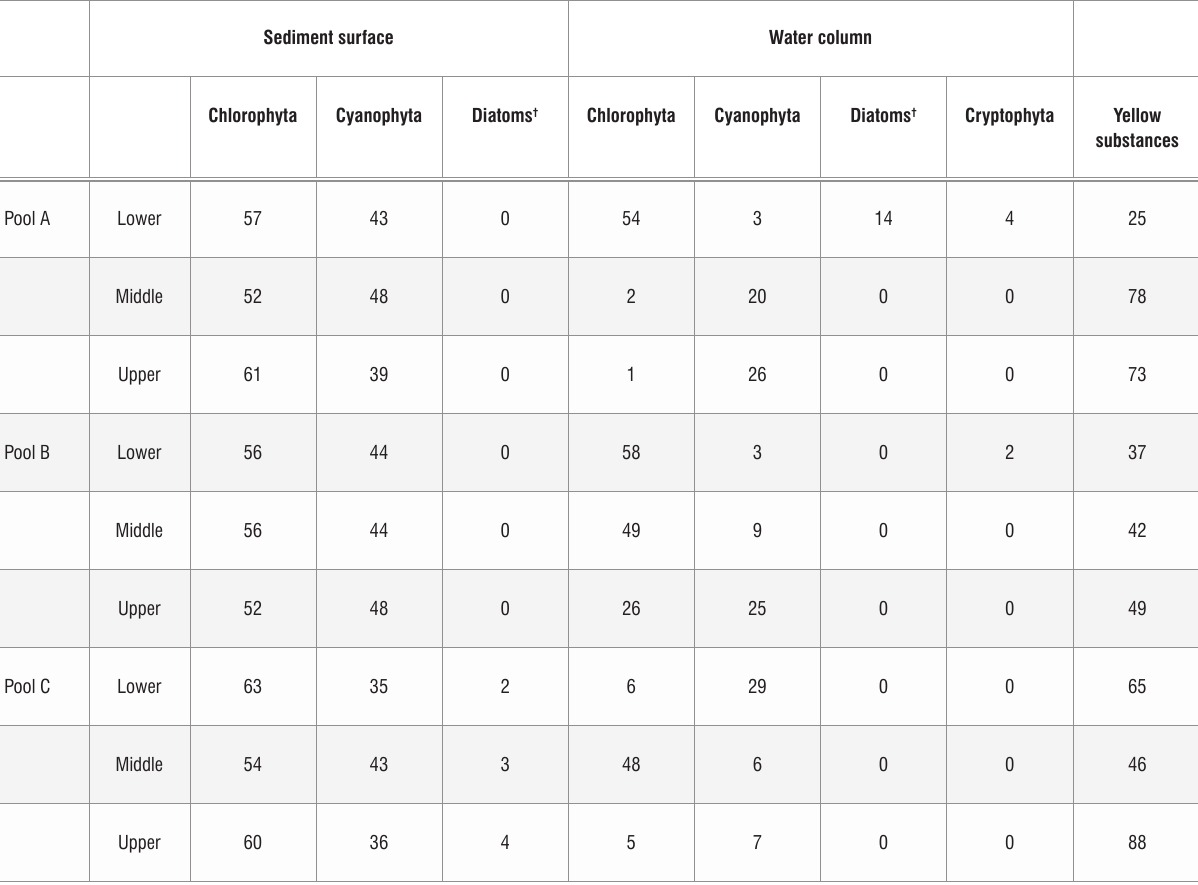
Table 2: Relative contribution (%) of total biovolume for algal classes discriminated by the bbe Moldaenke FluoroProbe in the water column and at the sediment surface of stromatolite Pools A–C during October